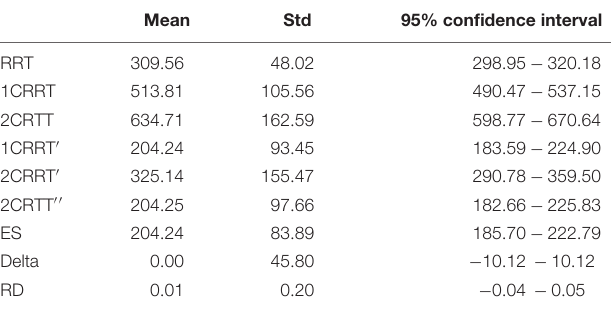
TABLE 2 | General results.